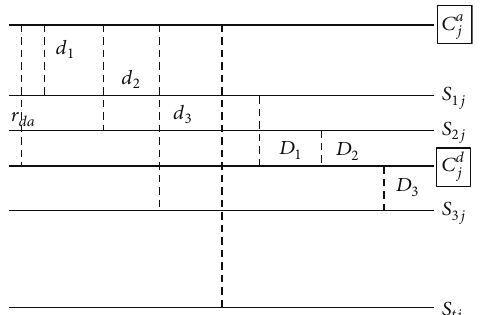
Figure 2: The impact of selection attribute preference on the